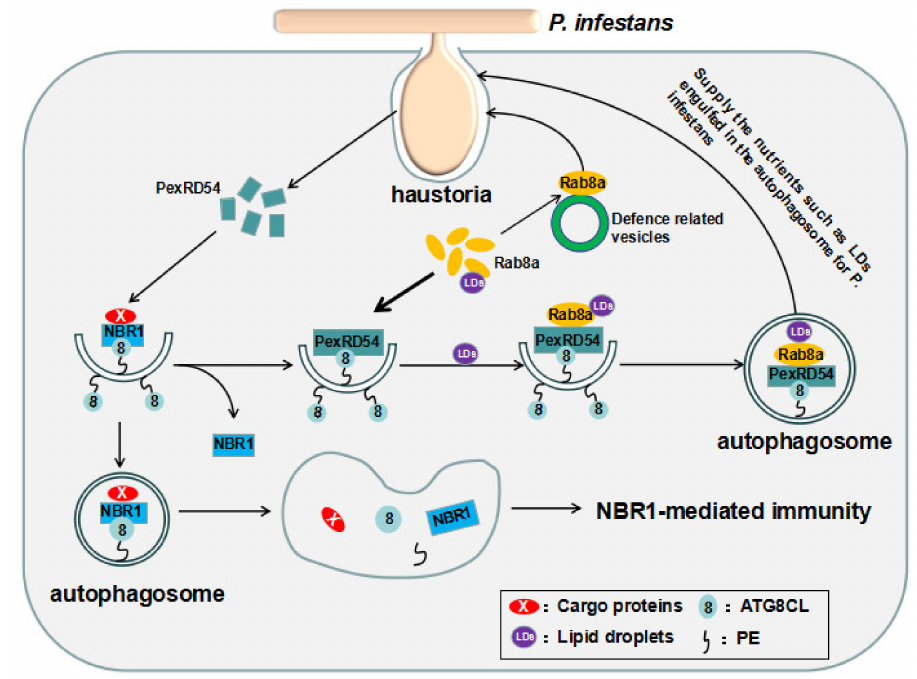
Figure 2. The e ff ector secreted from Phytophthora infestans , PexRD54, functions as a receptor to